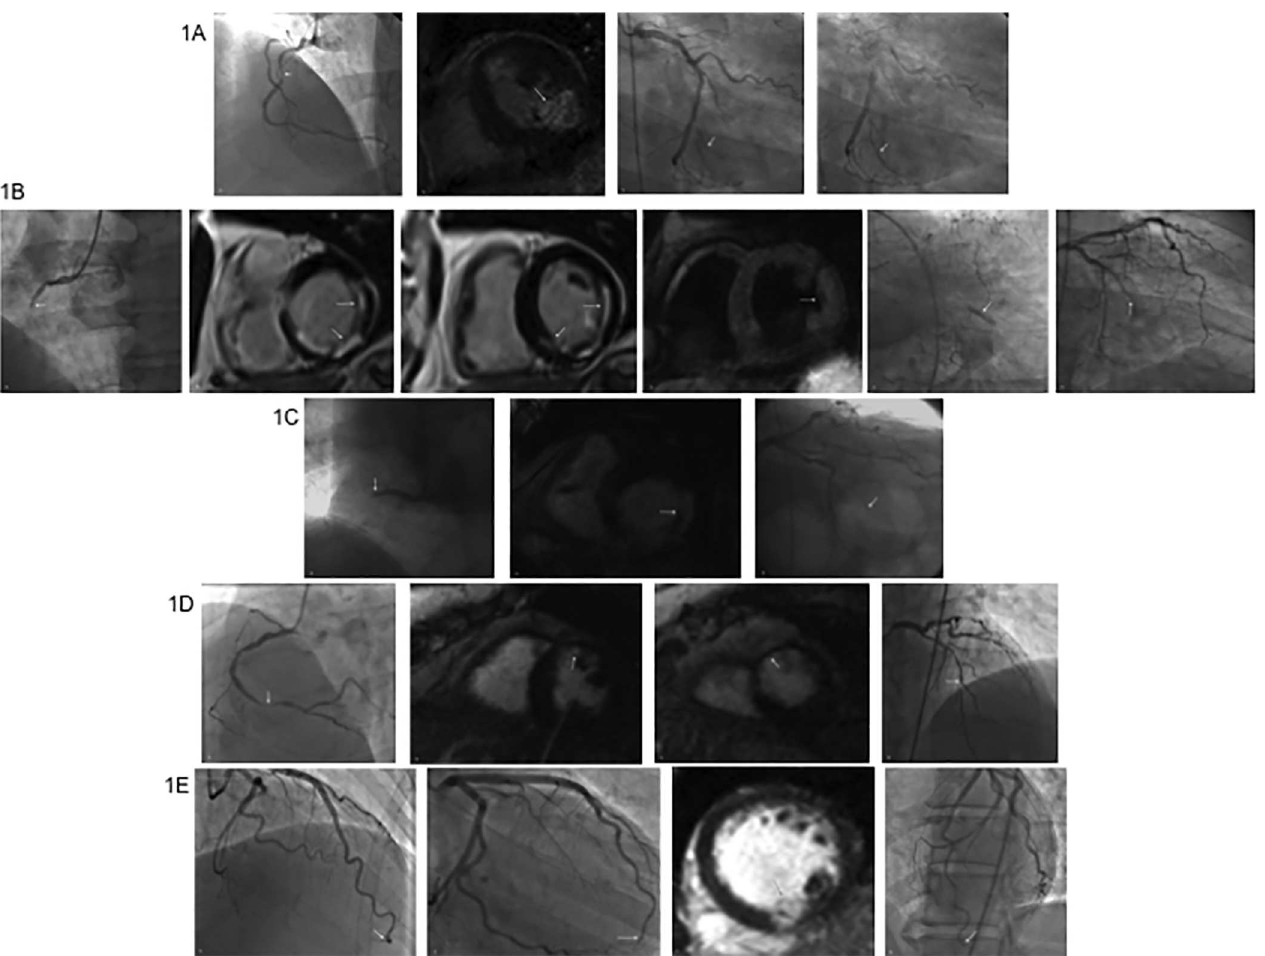
Fig 1. Mismatch between Cardiac Magnetic Resonance and Angiography. 1A: The clinicalinterpretation of the IRA was the RCA (white arrow), (A) which underwentPCI with stent placement.The IRA was indeterminateby blindedanalysis. CMR showedan inferolateral wall infarct (white arrow) (LCx distribution) (B). With the CMR data available,reviewingthe angiography data again, the OM was seen to have a flush occlusion that was filled retrograde(white arrows) (C and D). 1B: The clinical and blinded interpretation of the IRA was the RCA, which underwent PCI with stent placement(white arrow) (A). CMR showedinfarcts in both the RCA and LCx distribution (white arrows) (B and C). T2 weightedimaging indicatedthat the OM territory was acute (white arrow) (D). With the CMR data available,angiography revealed retrogradefilling of OM (white arrows) (E and F). 1C: The clinicaland blindedinterpretation of the IRA was the RCA, which underwent PCI with stent placement(white arrow) (A). CMR showedan infarct in the inferolateral (LCx) distributionwith no scar in the inferoseptal wall (white arrow) (B). There was also retrogradefilling of the OM (white arrow) (C). 1D: The clinicaland blindedinterpretation of the IRA was the RCA, which underwentPCI with stent placement(white arrow) (A). CMR showed an infarct in the mid-distalanterior wall (LAD distribution)(white arrows) (B and C). On cardiacangiography, there was stenosis noted in the mid-LADterritory (white arrow) (D). 1E: The clinical and blindedinterpretation of the IRA was the LAD, which underwent balloonangioplasty (white arrow) (A and B). CMR showedan infarct in the inferoseptalwall, (gray arrow) (C) which does not correlate with the area of distribution of the distal LAD. This area of distribution,is attributed to the PDA, which originatesfrom the LCx, howeverno obviousstenosis was appreciated in that region(white arrow) (D).